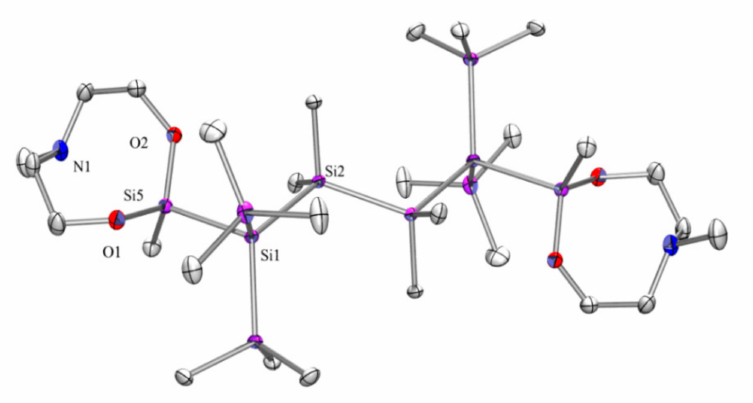
Figure 1. Molecular structure of 5 (thermal ellipsoid plot drawn at the 30% probability level). All hydrogen atoms are omitted for clarity (bond lengths in Å, angles in deg). Si(1)-Si(3) 2.3451(9), Si(1)-Si(5) 2.3564(9), Si(1)-Si(2) 2.3643(9), Si(2)-C(1) 1.885(3), Si(5)-O(2) 1.6456(17), Si(5)-O(1) 1.6474(17), N(1)-C(14) 1.440(4), O(1)-C(10) 1.416(3), Si(4)-Si(1)-Si(3) 108.61(4), O(2)-Si(5)-O(1) 113.50(10), O(1)- Si(5)-Si(1)